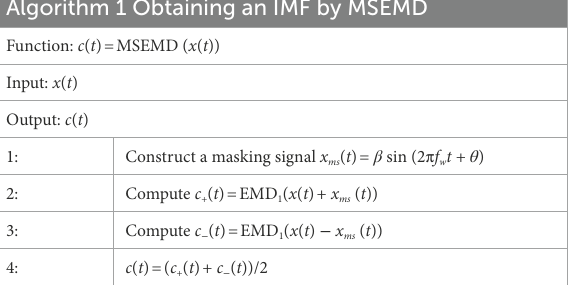
TABLE 1 The algorithm to obtain an IMF by MSEMD. Algorithm 1 Obtaining an IMF by MSEMD